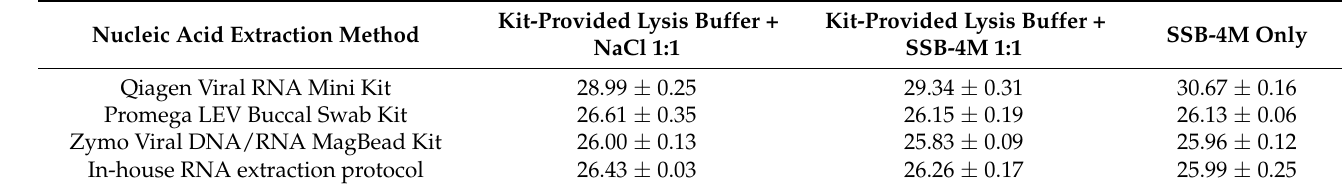
Table 2. Compatibility of SSB-4M with different commercial kits and an in-house RNA extraction protocol. Data shown are mean Ct values of five independent samples with standard